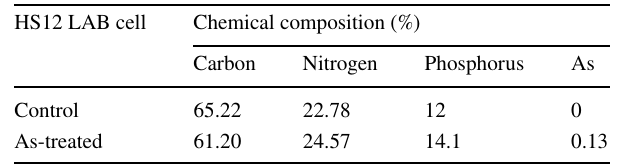
Table 2 Percentage composition of investigated As and other